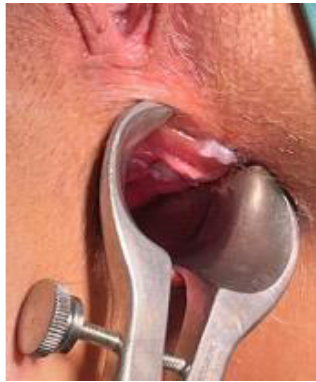
Figure 6. The inner and the outer parts of the membrane were sutured to the internal and external fistula opening by a 3-0 Vicryl suture, preventing its